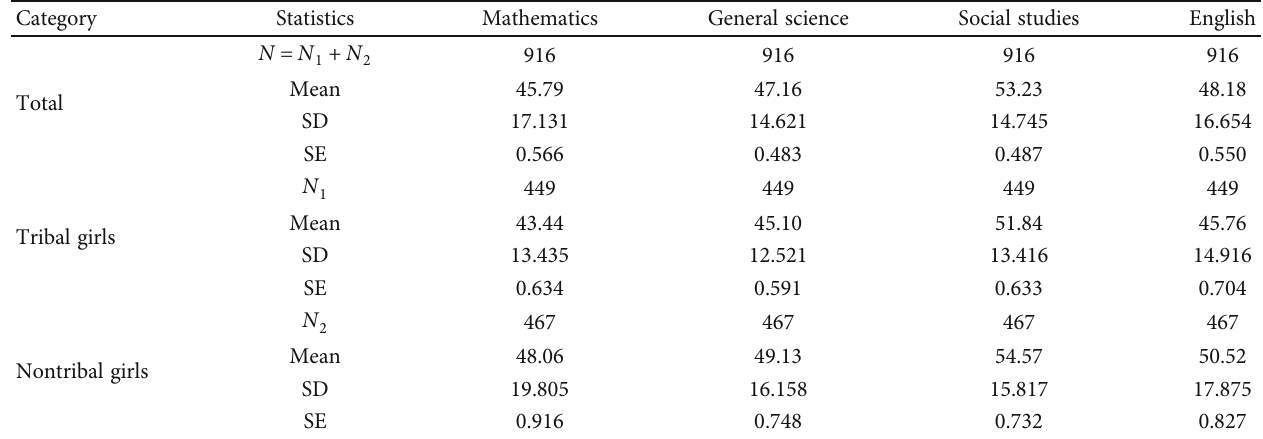
Table 13: The descriptive statistics for tribal girl and nontribal girl students.